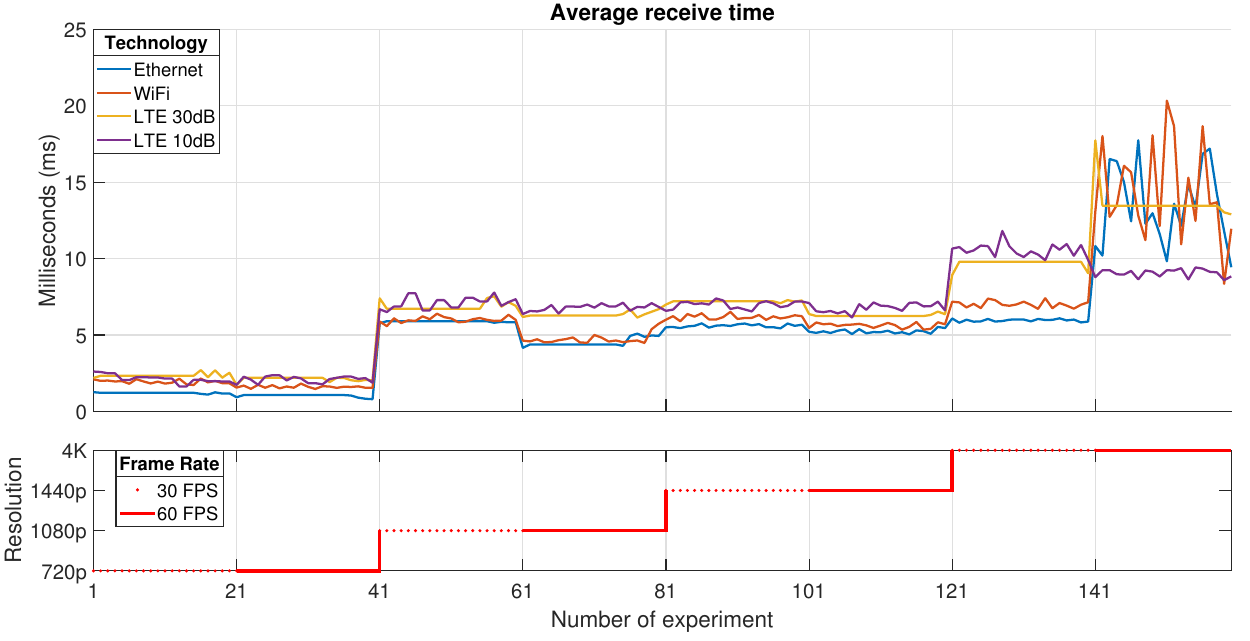
Figure 6. Average receive